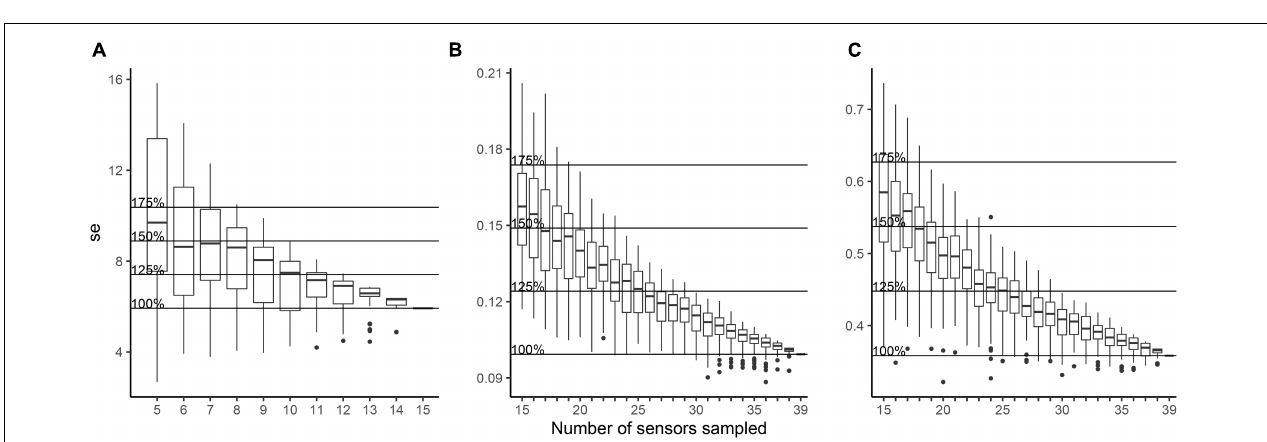
FIGURE 5 | Density plots of daytime records of radiation (A,B) , temperature (C,D) , and RH (E,F) for each canopy zone and for the leaf-out (A,C,E) and foliaged phases (B,D,F) .